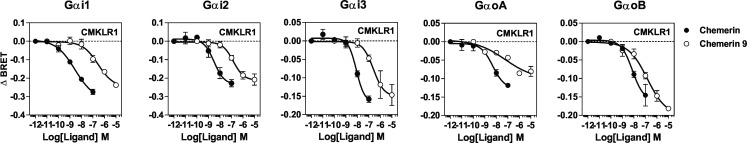
Activation of Gαi and Gαo by CMKLR1.Real-time measurement of BRET signal in HEK293T cells expressing G protein biosensors and CMKLR1, following stimulation for 1 minute with increasing concentrations of chemerin (●) or the chemerin-9 nonapeptide (◯). Results are expressed as the difference in BRET signals measured in the presence and absence of chemerin. Data represent the mean ± S.E.M. of three independent experiments.